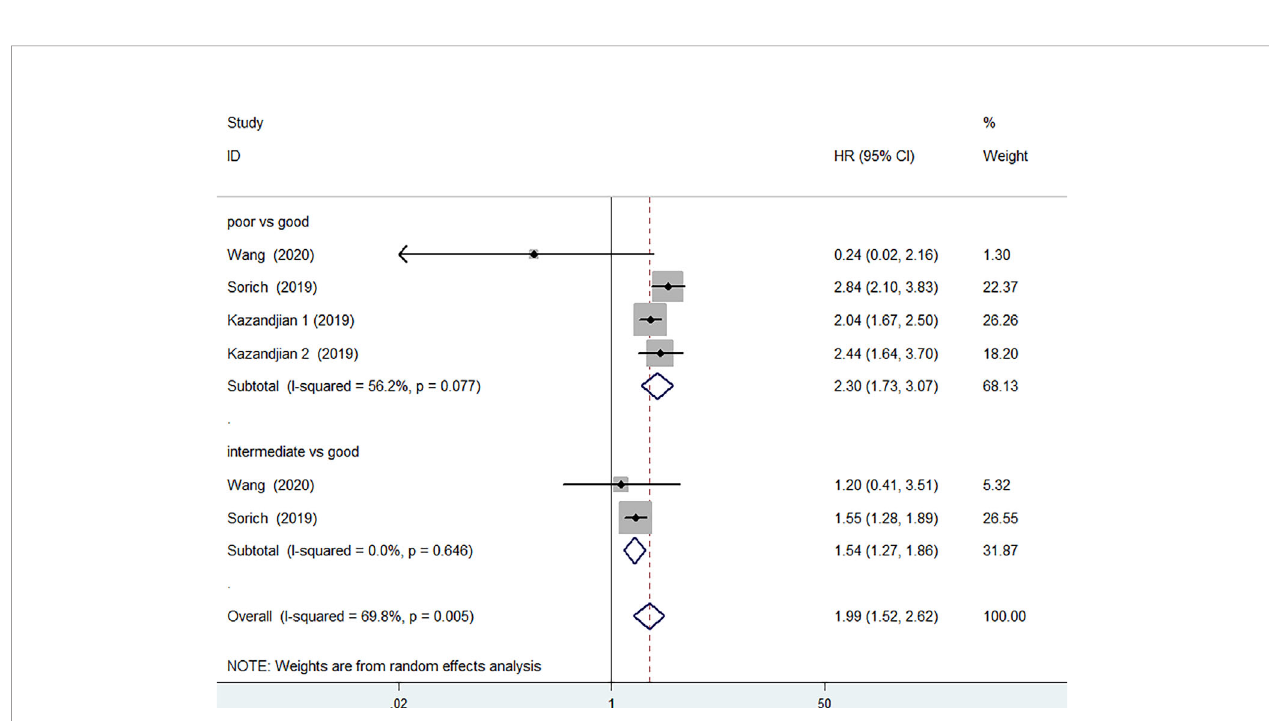
FIGURE 5 | Meta-analysis of OS in cancer patients after chemotherapy (poor LIPI score groups vs. good LIPI score groups, intermediate LIPI score groups vs. good LIPI score groups).